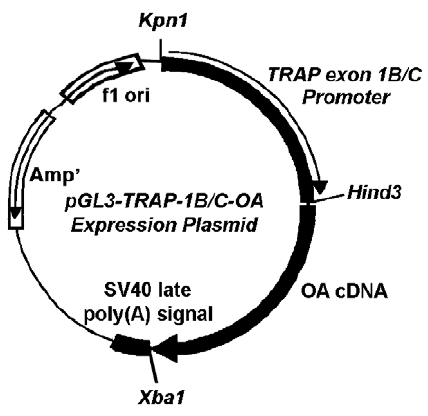
Figure 1. Schematic representation of the pGL3-TRAP-1B/C- OA expression plasmid. The pGL3-TRAP-1B/C- OA expression plasmid was generated by cloning the full-length mouse OA cDNA into the Hind3/XbaI restriction site of the pGL3-basic vector. The TRAP-1B/C promoter was then cloned into the Kpn1/Hind3 restriction